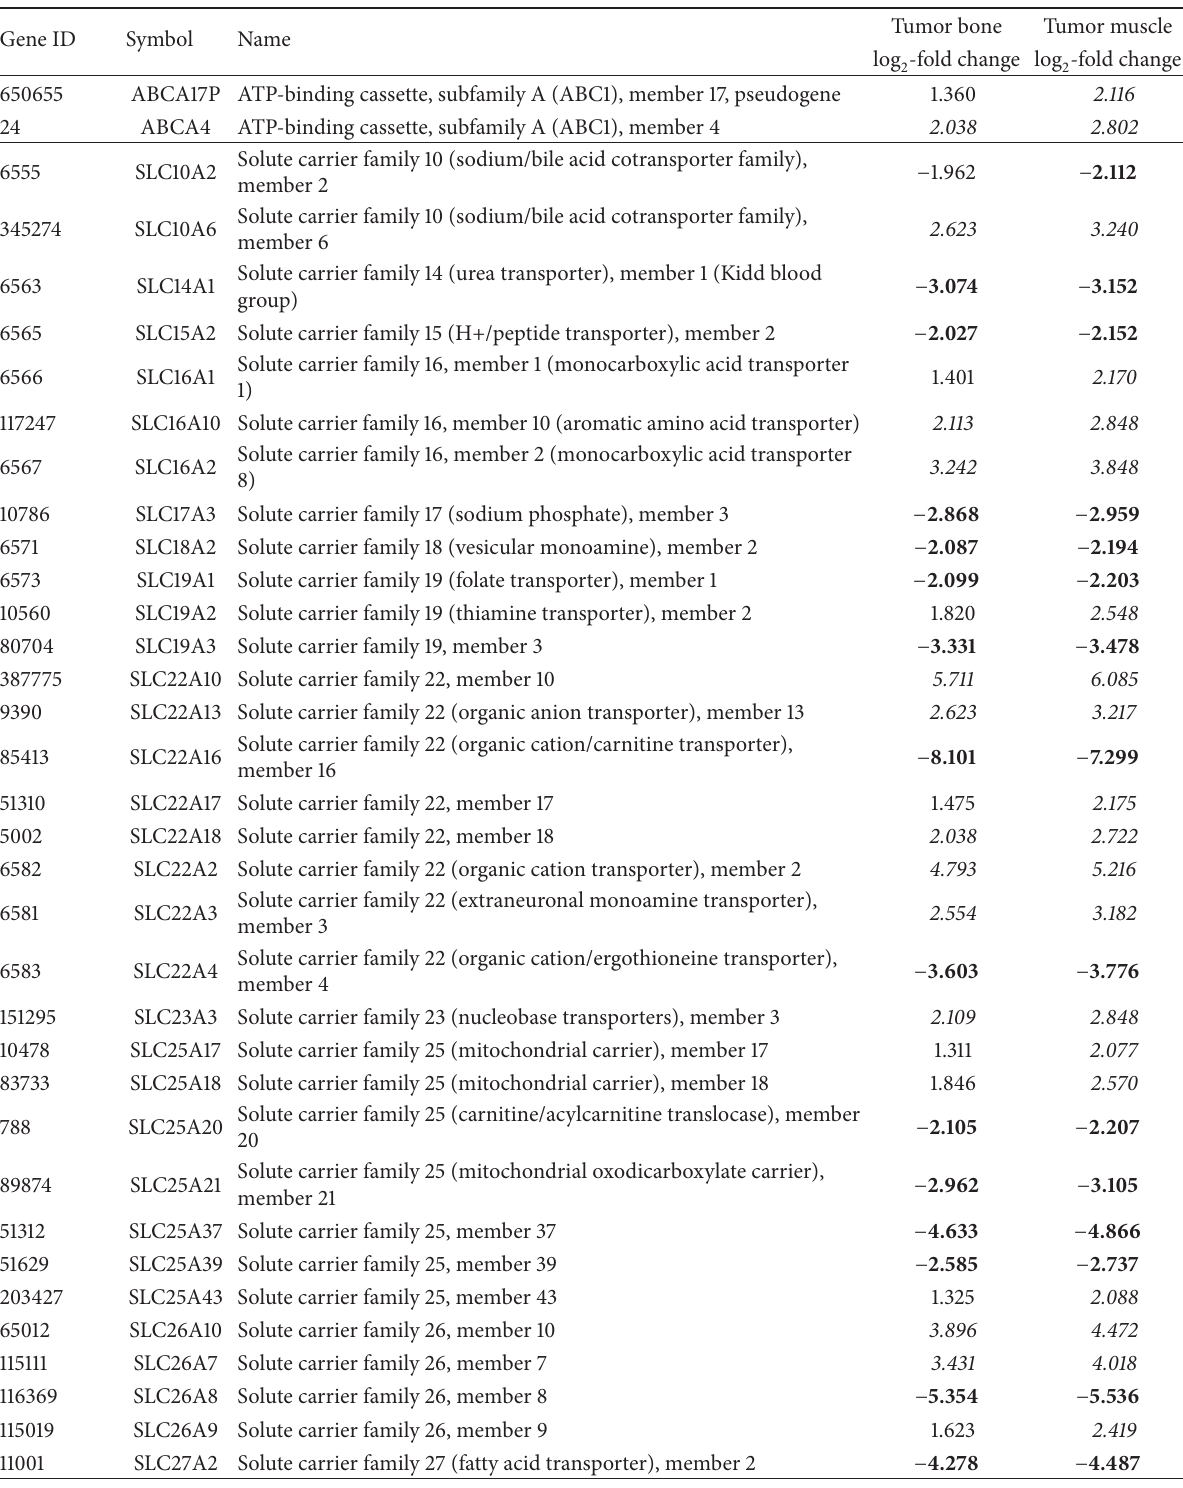
Table 3: Deregulation of genes for drug disposition. Analysis of RNASeq for at least twofold overexpression (italic font) or underexpression (bold font) of genes for (a) transport and (b) metabolism in tumor compared to muscle and bone. For the export transporters (ABC transporters), only overexpression is considered relevant for drug resistance. Not shown in the table are the underexpressed genes